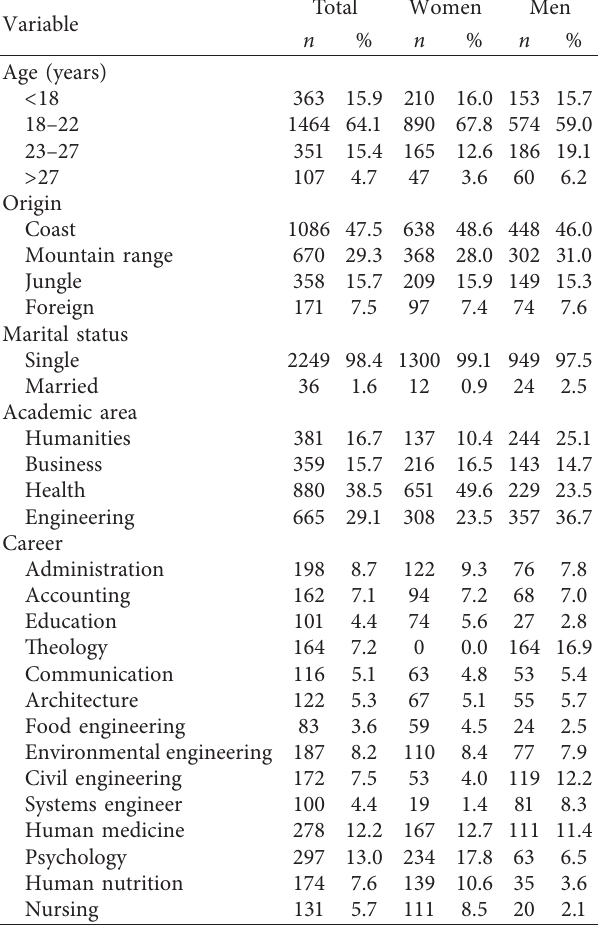
Table 1: Sociodemographic characteristics of university students.